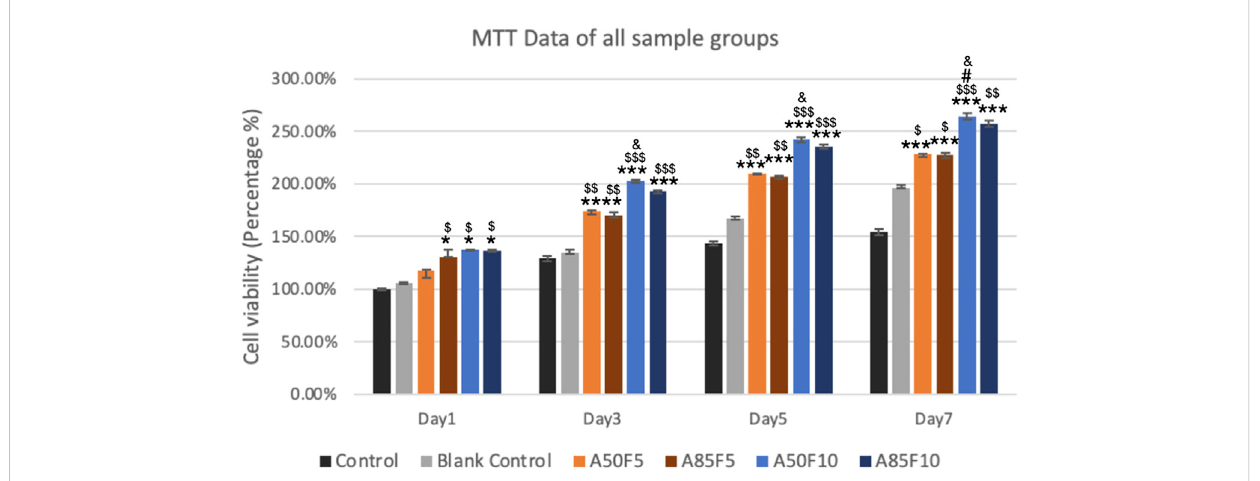
FIGURE 9 Increased cell proliferation and viability of surface treated samples especially fi bronectin treated groups (blue lines) can be seen from day 1 to day 7 by using MTT analysis (Signi fi cant difference compared with control is indicated with *, p < 0.05, **, p < 0.005, and ***, p < 0.001, while $ symbol for comparing with blank control, # for A50F5 and, & symbol is applied for comparing with A85F5).